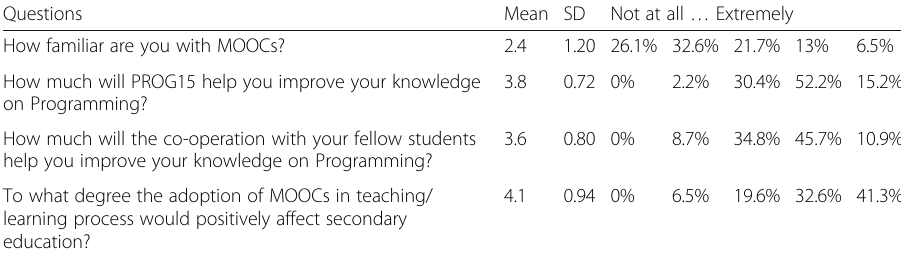
Table 3 Students ’ responses in the before-PROG15 questionnaire ( Ν = 46) Questions Mean SD Not at all … Extremely